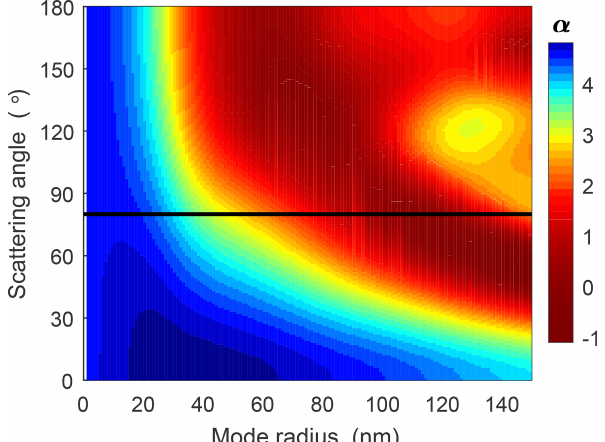
Figure 10. A lookup table for the NLC particle size analysis, gen- erated from T-matrix simulations. Shown is the Ångström exponent as a function of mode radius and scattering angle. The black line indicates a typical scattering angle for MATS NLC observations.